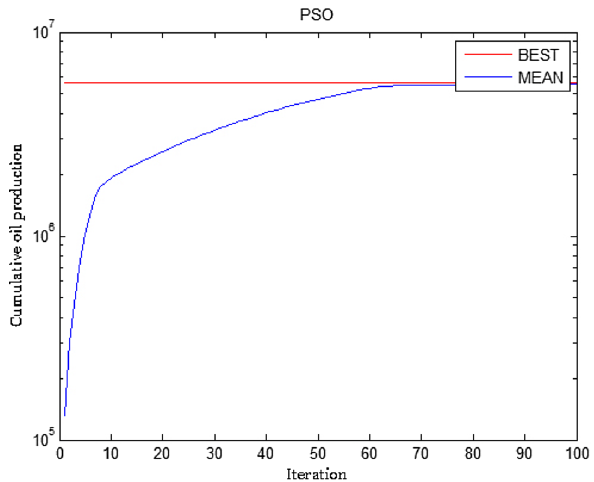
Fig. 25 Result of PSO algorithm for cumulative production under optimum conditions of